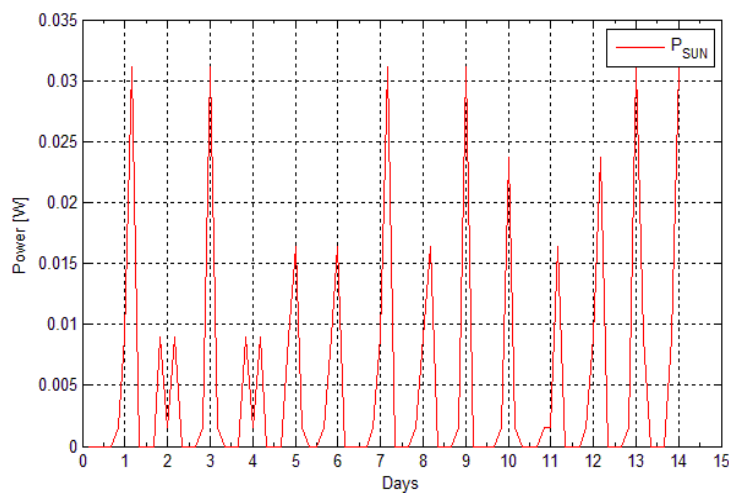
Figure 7. Harvested power from sun—deployment (II).